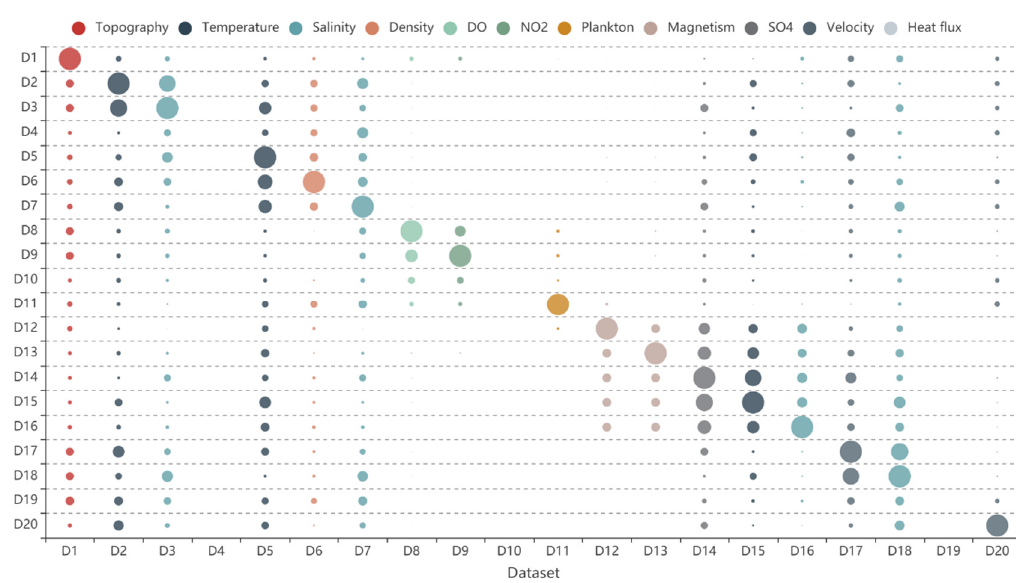
Figure 9. Data similarities of datasets.